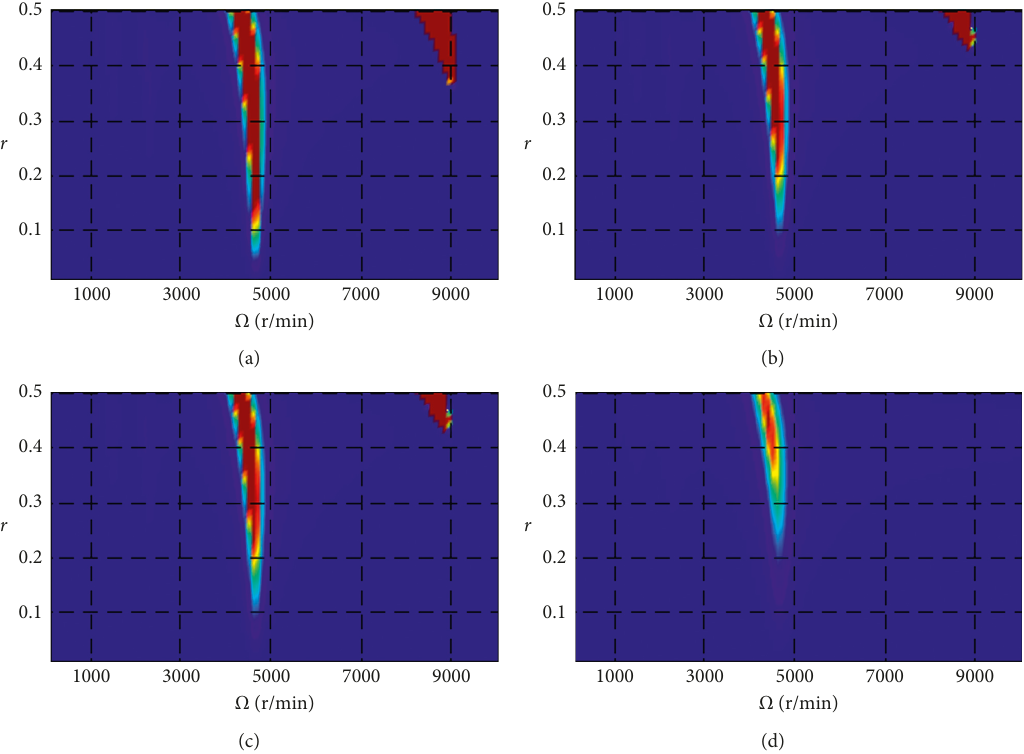
5 m and β 1 10 1/2 π for various damping ratios: (cid:31) × (cid:31) −